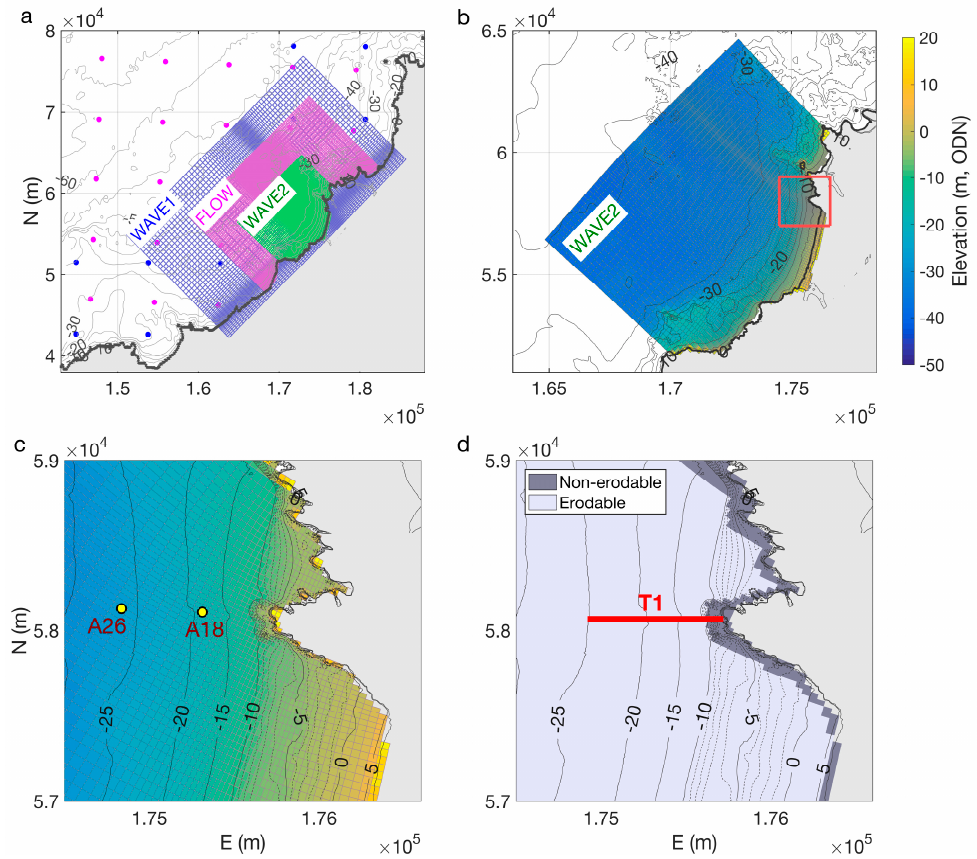
Figure 2. Delft3D model grids: ( a ) WAVE and FLOW model grids, blue dots indicate Wave Watch III (WW3) wave model nodes (see Section 3.2.1), pink dots indicate Forecasting Ocean Assimilation Model 7 km Atlantic Margin model (FOAM-AMM7) hydrodynamic model nodes (see Section 3.2.2); ( b ) WAVE2 grid; ( c ) FLOW grid in vicinity of Perranporth north headland; and ( d ) erodibility grid with transect used for analysis (T1) indicated.